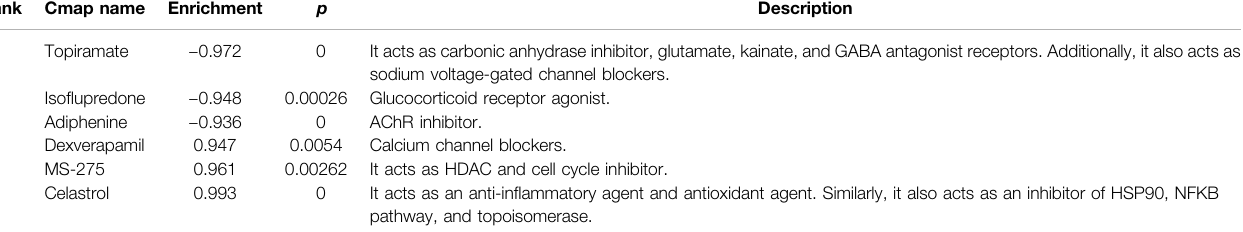
TABLE 1 | Top six small molecules with the highest absolute enrichment values identi fi ed with DEGs.